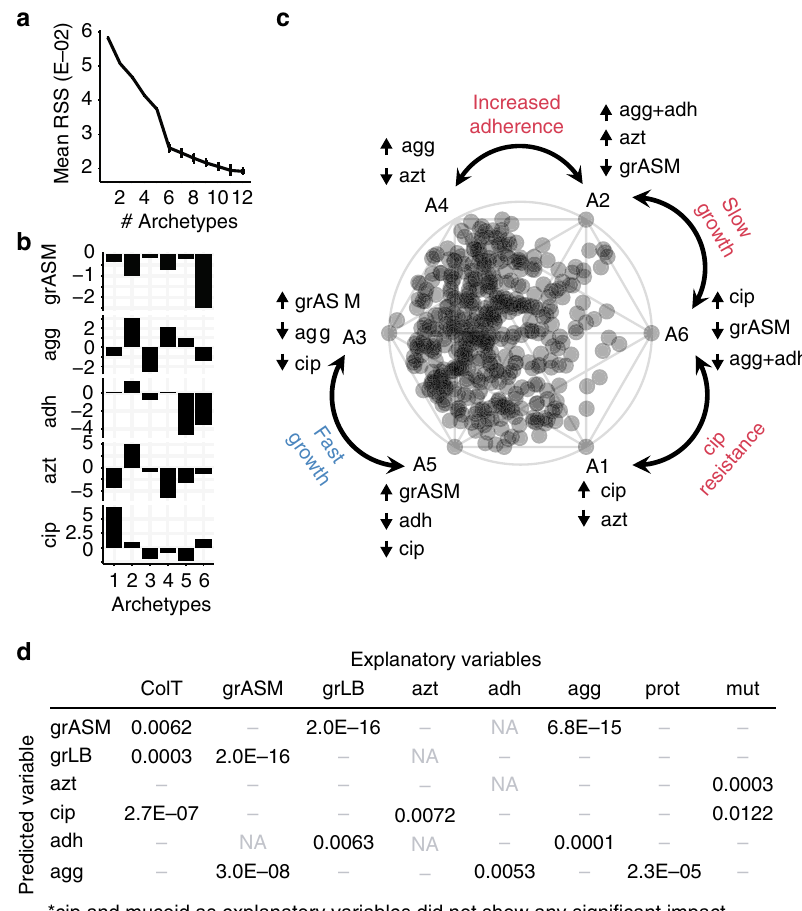
Fig. 3 AA and GAMM models. We present a summary of the models underpinning our study of pathogen adaptation. a Screeplot showing the average residual sum of squares (RSS) for 25 iterations of each fi t of a given number of archetypes. The “ elbow ” of the plot indicates that six archetypes are suf fi cient to model our dataset. b Characteristic trait pro fi les describing the fi ve distinct phenotype levels that each of our 6 archetypes represents. We use the following abbreviations to represent our normalized data: grASM for growth rate in ASM, agg for aggregation, adh for adhesion, azt for aztreonam susceptibility, and cip for cipro fl oxacin susceptibility. c Simplex plot of the AA showing the six archetypes (A1 – A6) sorted by their characteristic growth rate (A3 and A5 vs A2 and A6), decreased sensitivity towards cipro fl oxacin (A1 and A6), and increased aggregation and adhesion (A2 and A4). All further simplex visualizations are also sorted accordingly and can be interpreted using this key, which is annotated with the extreme phenotype values for each archetype. The complete analysis can be found in Supplementary Note 1. d P -values for GAMM models with multiple explanatory variables (columns) for the six predictor variables (rows) after model reduction. P -values are only shown for explanatory variables that showed a signi fi cant ( p -value<0.01, GAMM with Wald-type tests) impact on the predictor in question. The complete analysis can be found in Supplementary Note